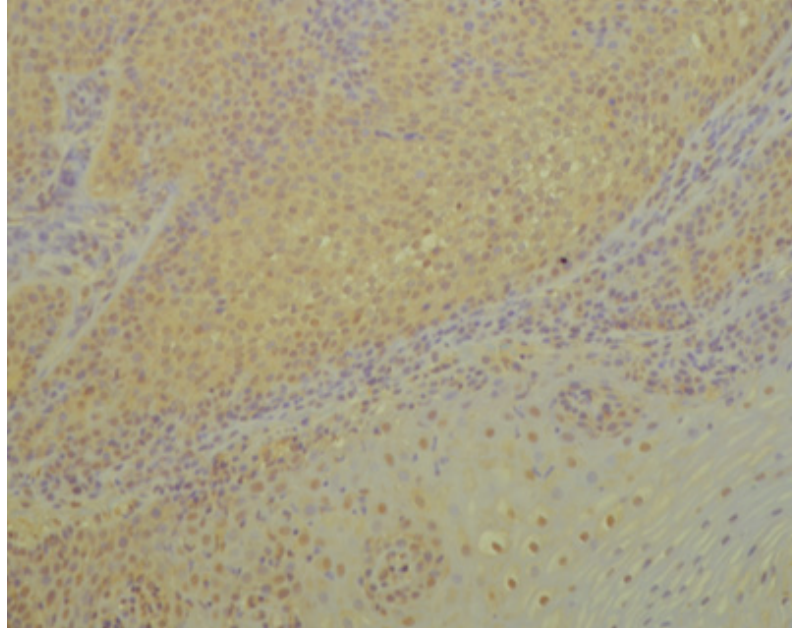
Figure 1. IL-1 α —moderate brown staining in all epithelial cells of oral squamous cell carcinoma (OSCC) (20x).